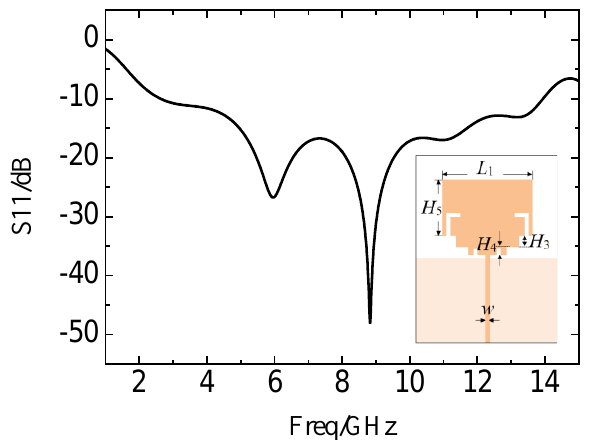
Figure 7. Simulation results of the reflection coe ffi cient curve after loading the I-shaped slot on the SIR.